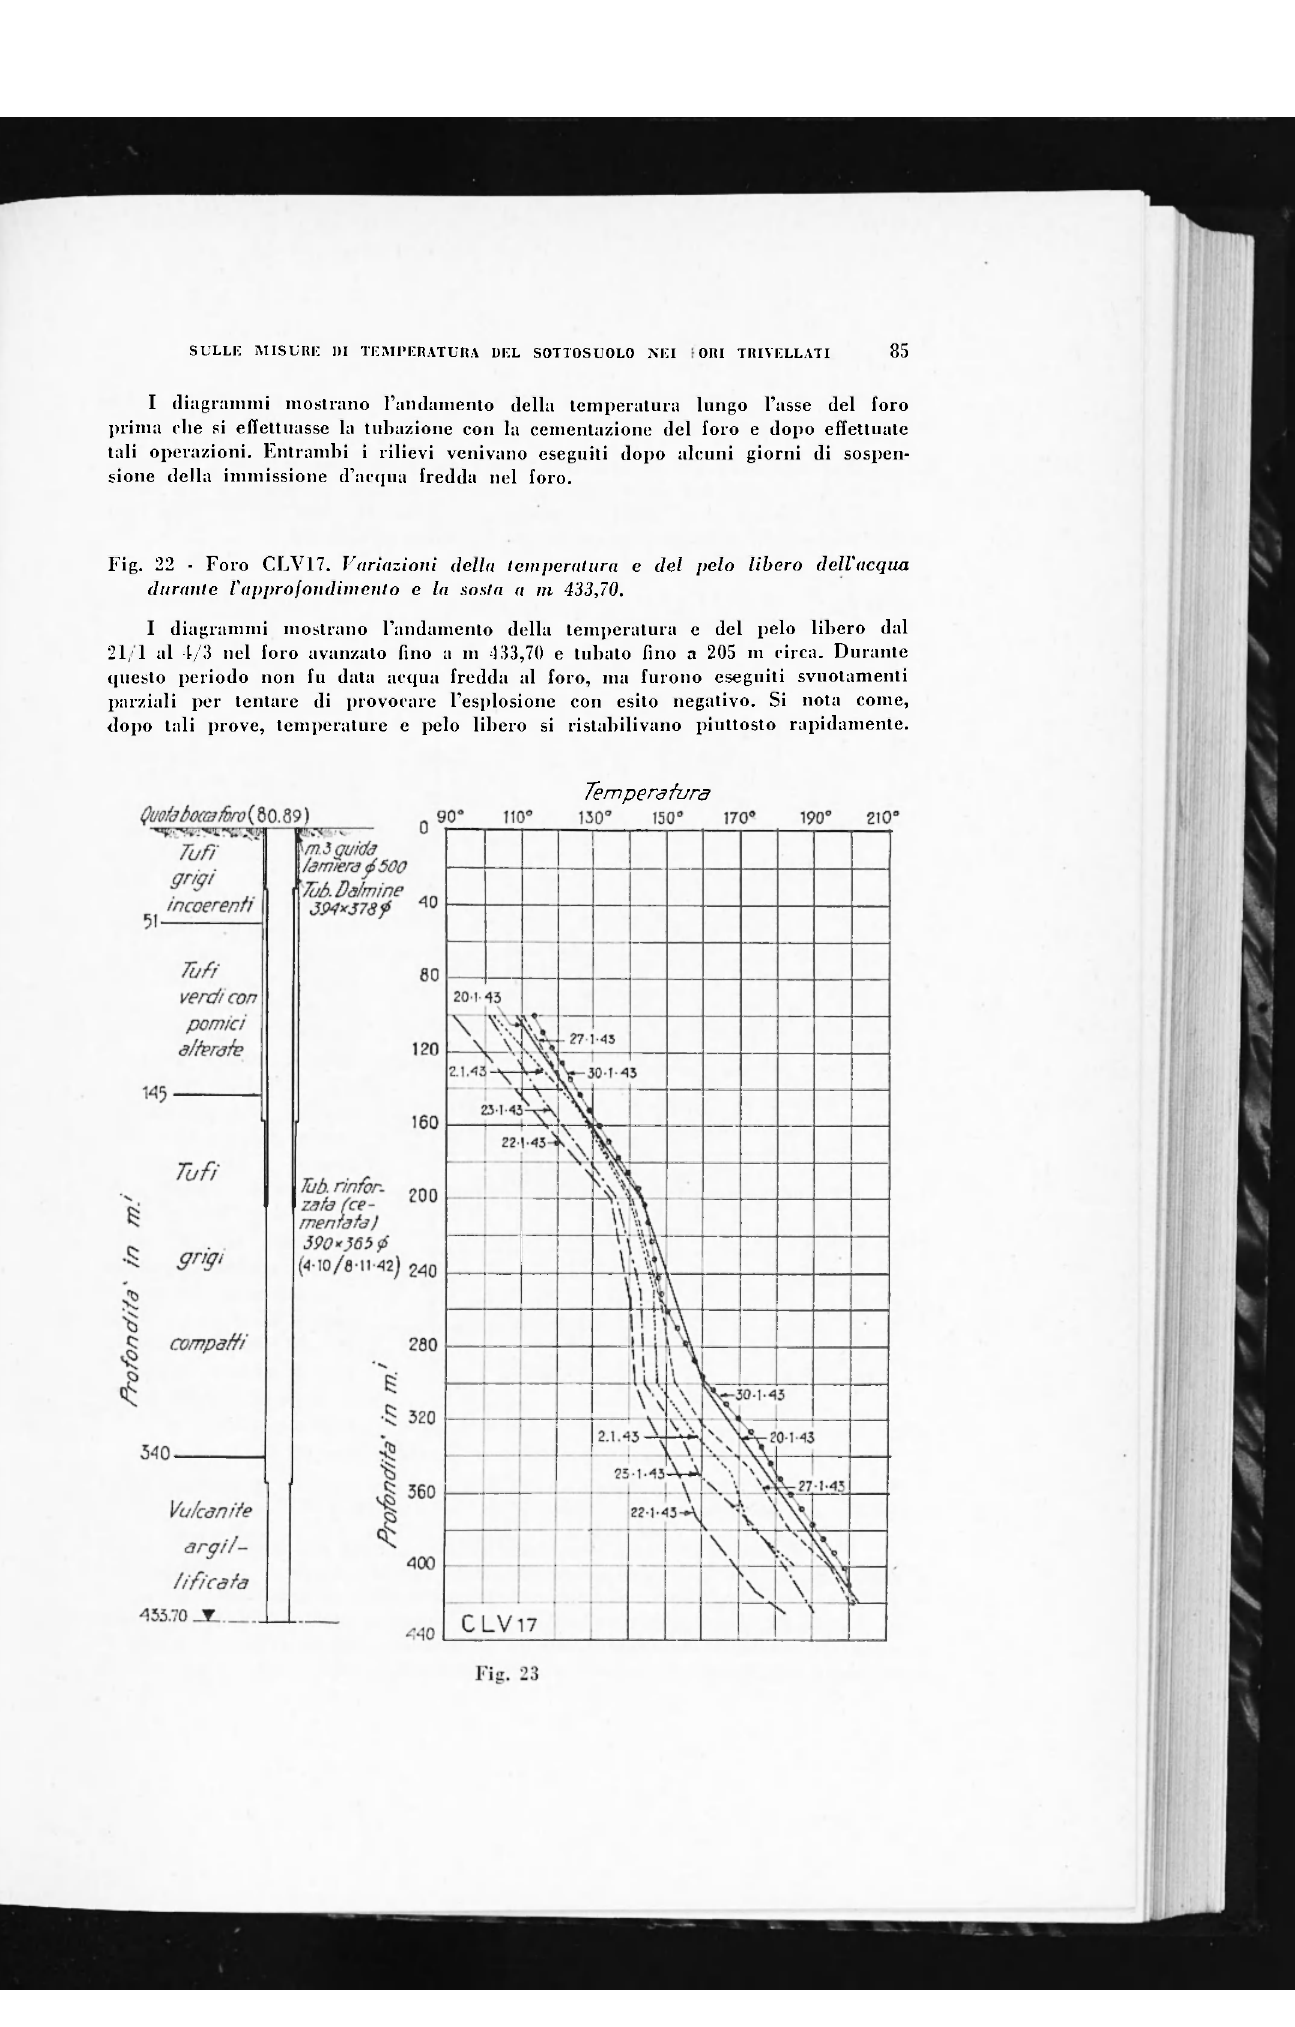
Fig. 22 - Foro CLV17.